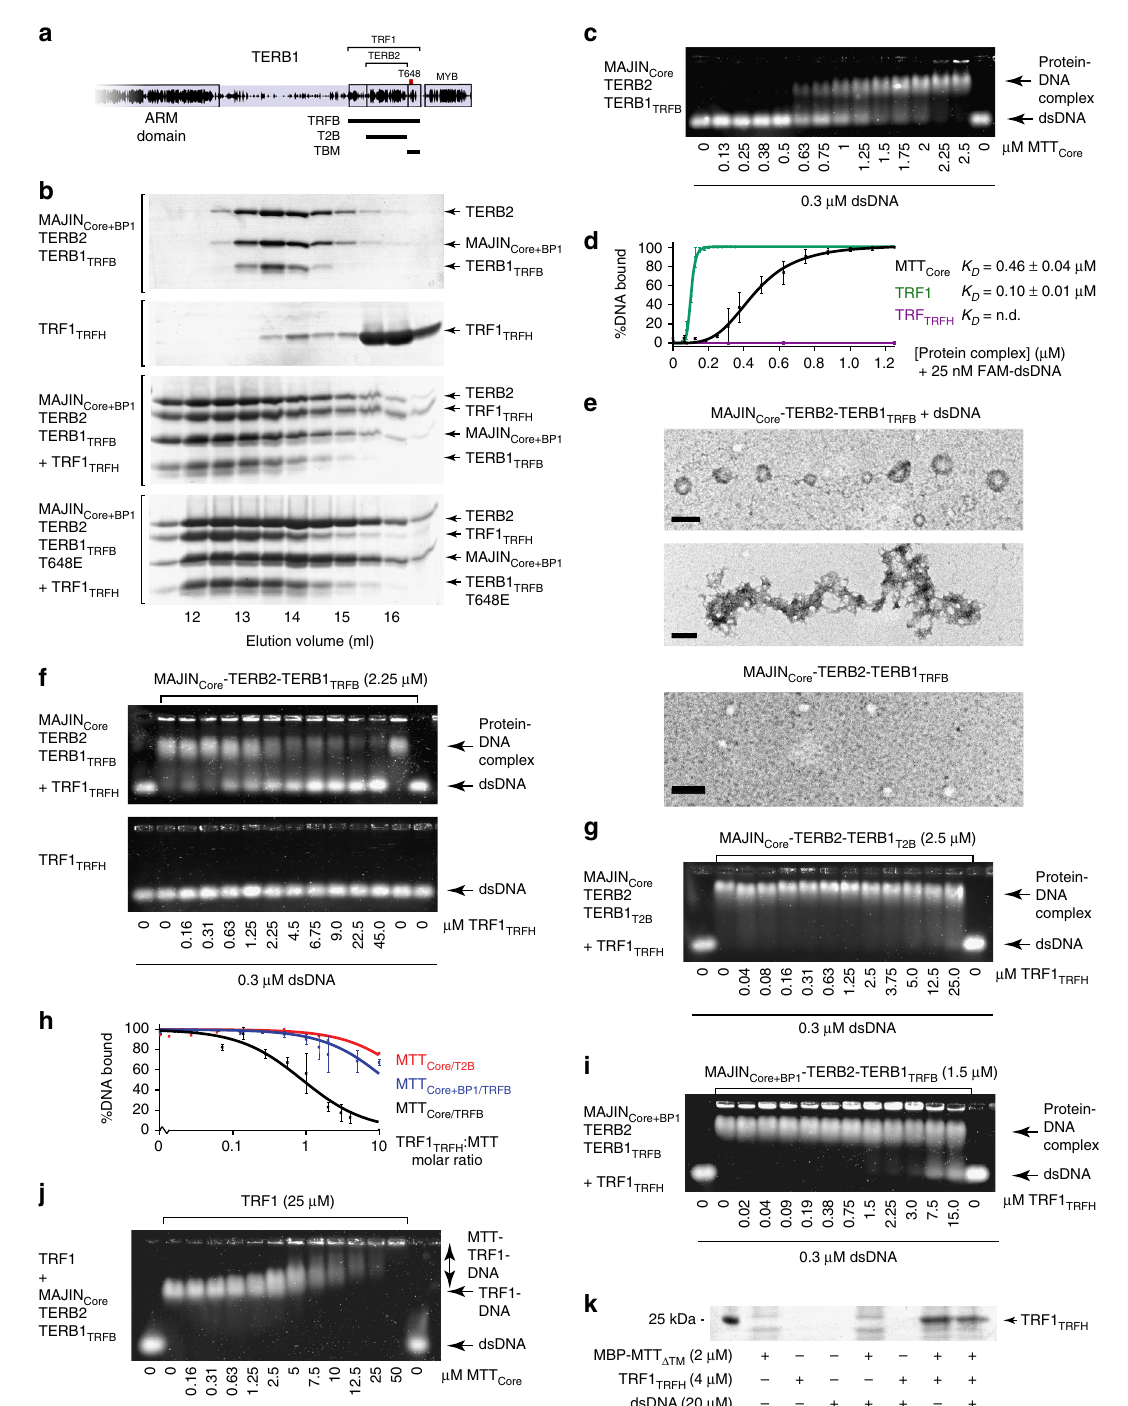
converted to mean residue ellipticity ([ θ 222 ]) and plotted as % unfolded ([ θ ] 222,x – [ θ ] 222,5 )/([ θ ] 222,95 – [ θ ] 222,5 ). Melting temperatures ( Tm ) were estimated as the points at which samples are 50%